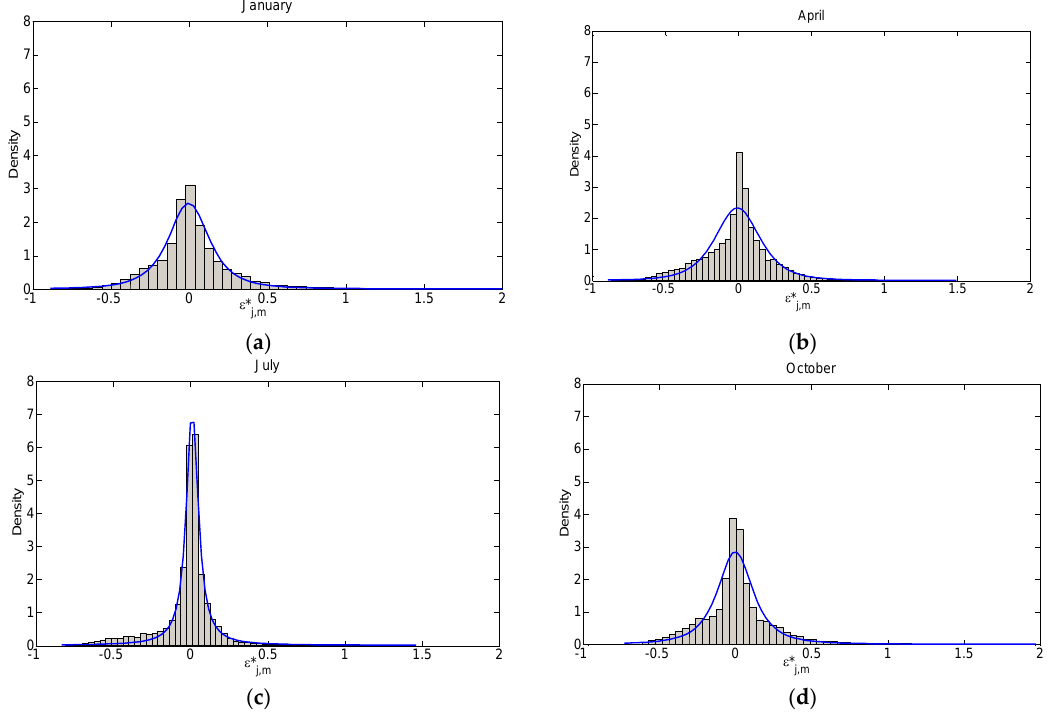
Figure 6. Discrete probability distributions of 𝛦 𝑚′∗ , and their fitting pdfs with reference to the months of ( a ) January; ( b ) April; ( c ) July; and ( d ) October.